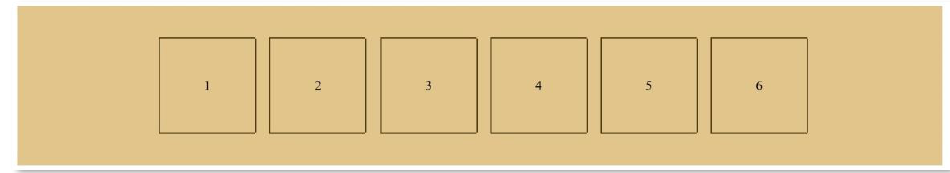
Figure 8. Square wooden board.